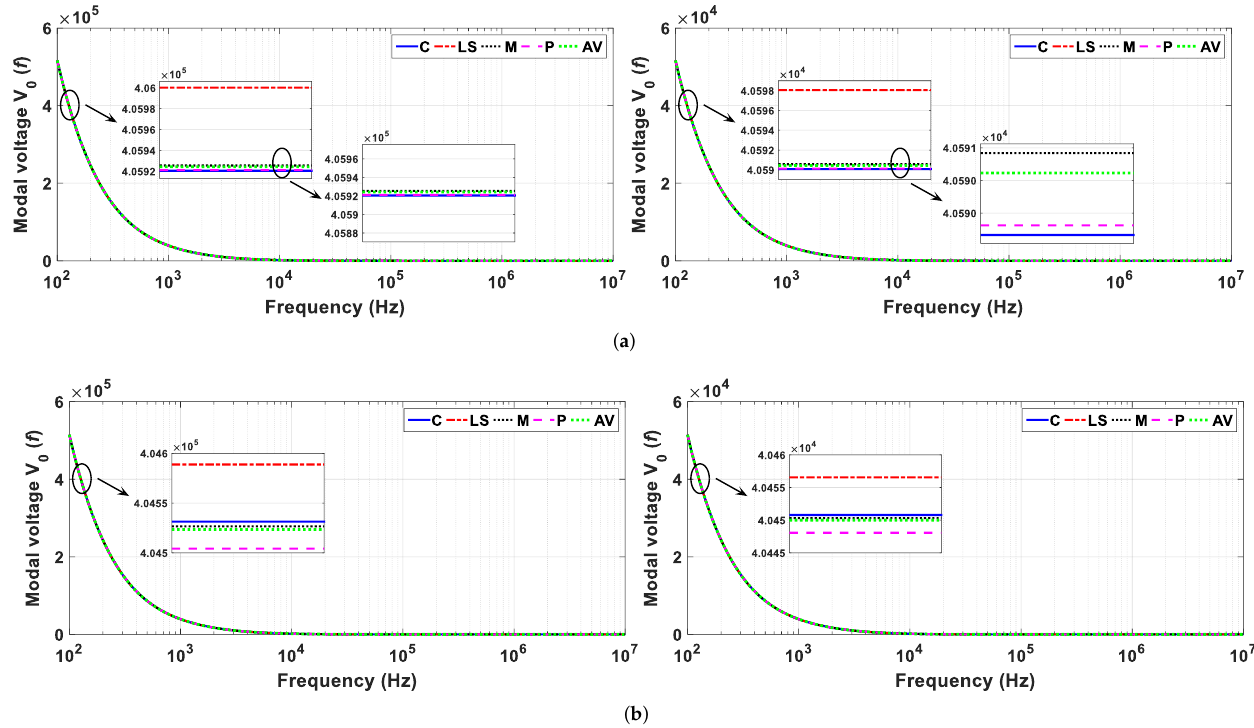
Figure 17. Transient voltages at the receiving end of mode 0 obtained for the lightning direct strike for the 1 km OHTL ( left ) and 10 km OHTL ( right ) with ρ 0 of: ( a ) 700 Ω · m and ( b ) 4000 Ω · m. Table 5. χ ( % ) for the frequency-domain voltage V α in mode α for the considered FD soil models. ρ = 700 Ω · m